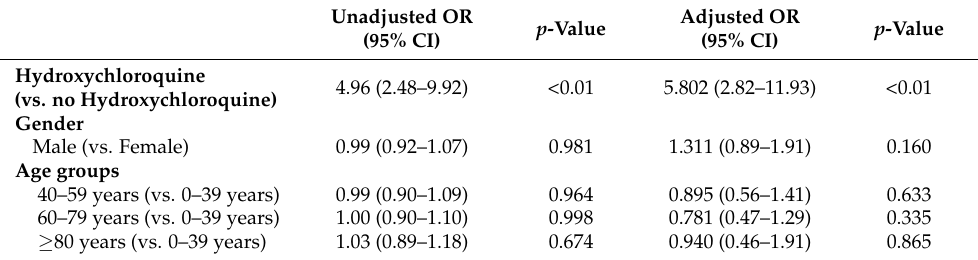
Table 3. Univariate and multivariate logistics regression of the risk of contracting COVID-19.